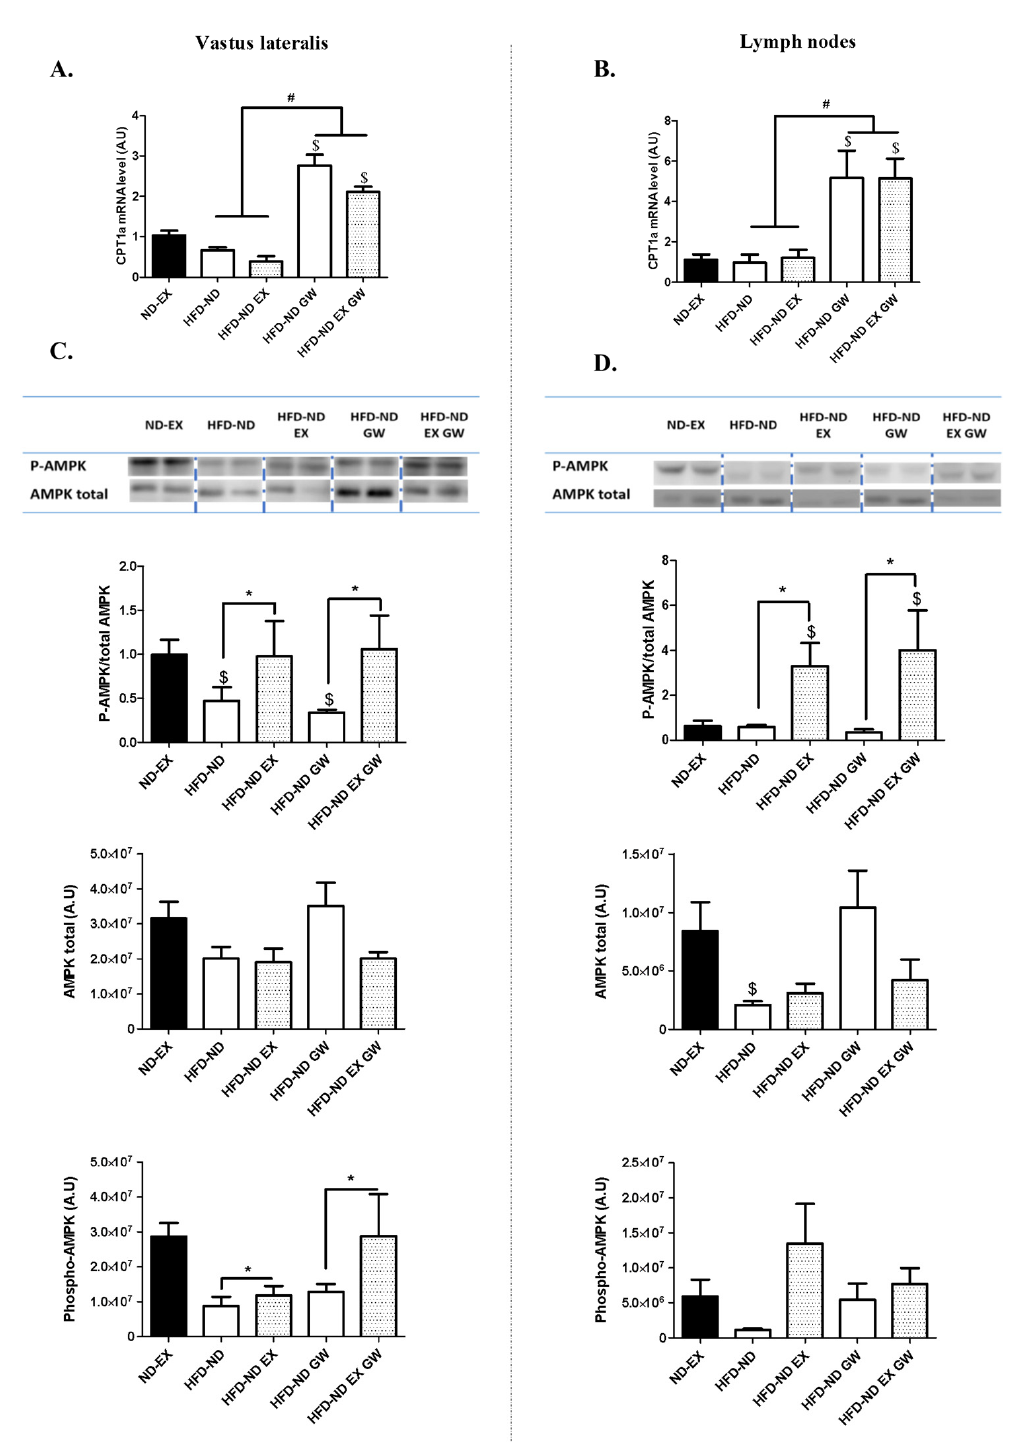
Figure 3. Carnitine palmitoyltransferase 1a (CPT1a) mRNA and AMP-activated protein kinase (AMPK) protein levels in skeletal muscle and lymph nodes. ( A ) CPT1a mRNA level in vastus lateralis and ( B ) in lymph nodes. ( C ) and ( D ) Phosphorylated (Thr172) AMPK and total AMPK protein levels measured by western blot in vastus lateralis ( C ) and in lymph nodes ( D ). Data are shown as mean ± SD. ( n = 6 per group). Blots are shown for n = 2 per group. * p < 0.05 exercise training effect (2-ways ANOVA); # p < 0.05 GW0742 effect (2-way ANOVA); $ p < 0.05 vs. ND-EX (one-way ANOVA). 2.3. Prevalence of CD4+Foxp3+ Regulatory T cells increases with GW0742 Treatment in Lymph Nodes. AMPK activity and FAO are known to be involved in Tregs fate. Tregs display high rates of FAO and an oxidative metabolic profile which is driven in part by Foxp3-dependent expression of genes